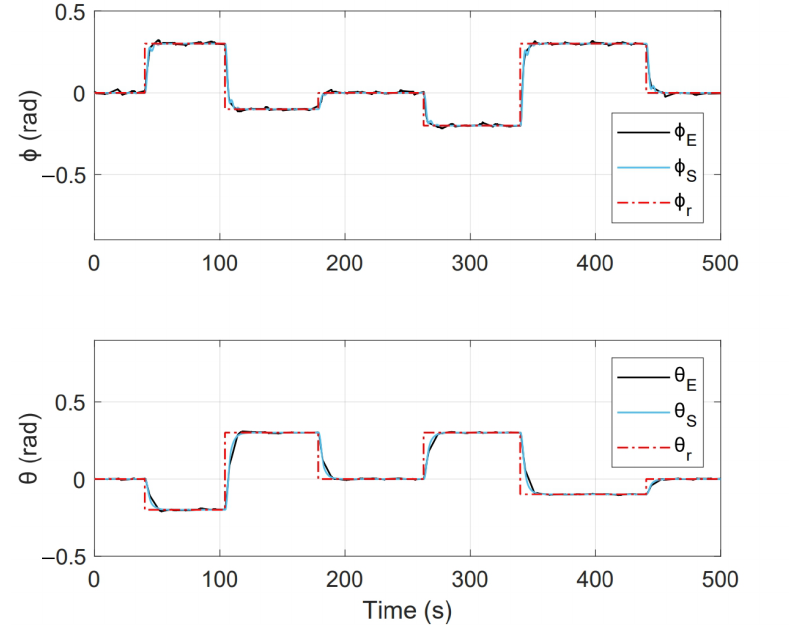
Figure 17. System response obtained in state feedback control